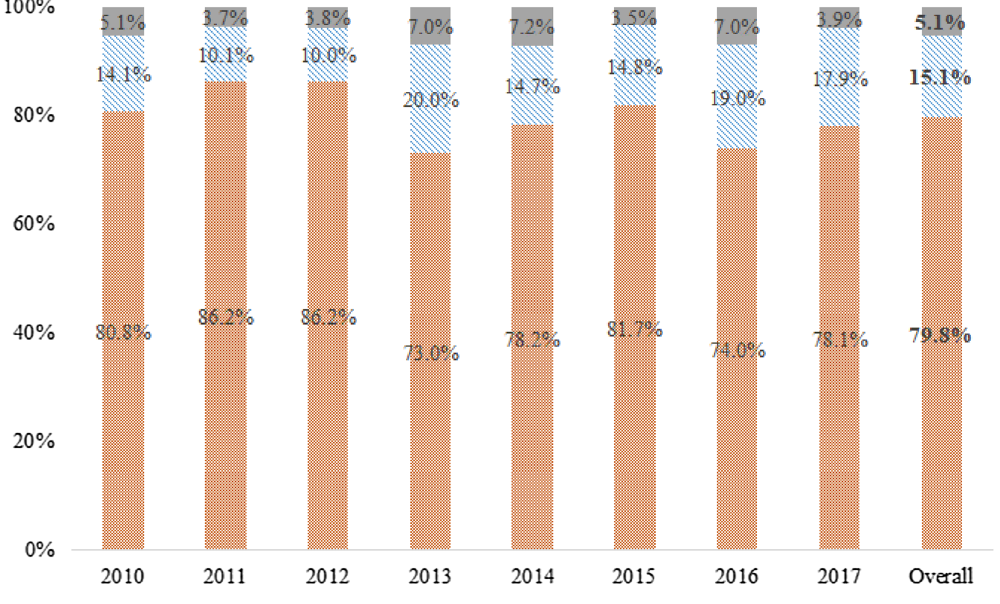
Figure 2. Proportion of patients diagnosed with chronic obstructive pulmonary disease (COPD) and diagnosed with other respiratory-related diseases (tuberculosis, asthma, and lung cancer) diagnosed among COPD